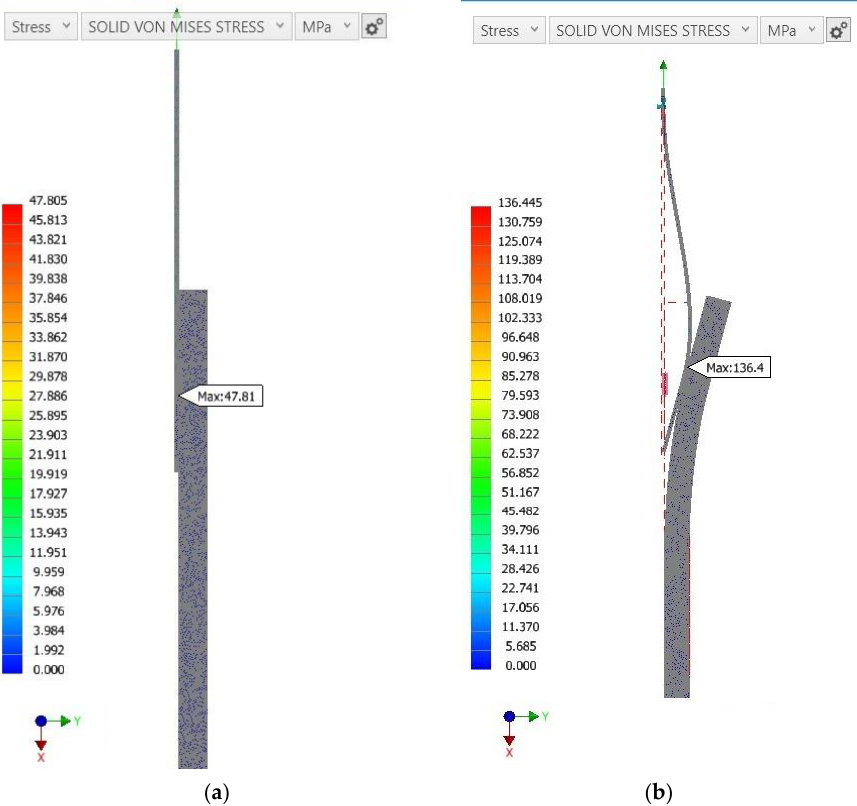
Figure 6. Comparison of tensile test with fixture ( a ); and without fixture ( b ), regarding Von Mises stress (MPa)